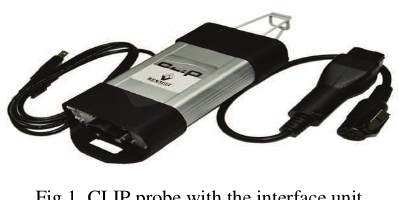
Fig.1. CLIP probe with the interface